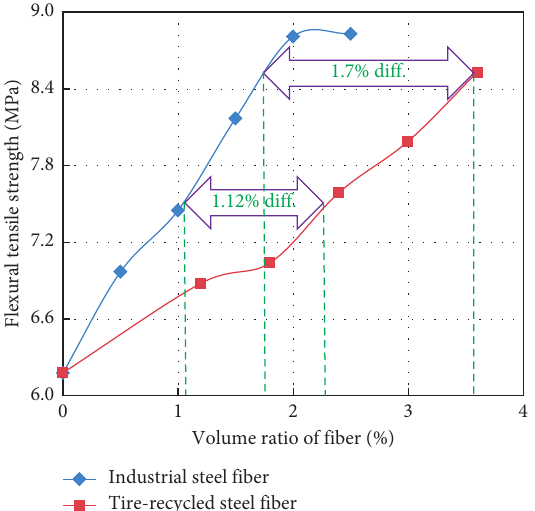
Figure 4: The flexural tensile strength of two types of steel fiber reinforced concrete.